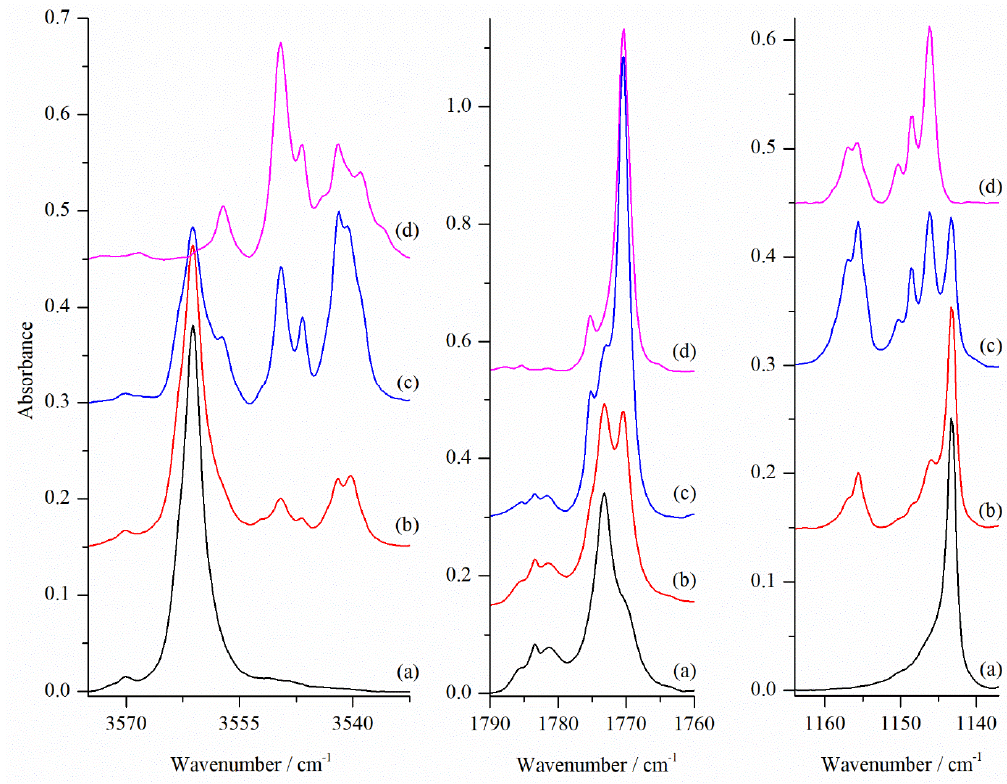
Figure 3. The ν OH, δ OH C and ν C = O regions of the infrared spectra of GA co-deposited with N 2 / Ar = 1 / 4000 at 15 K, 18 K and 25 K (measurement at 10 K) (traces ( b – d ), respectively, compared with GA / Ar spectrum ( a ).